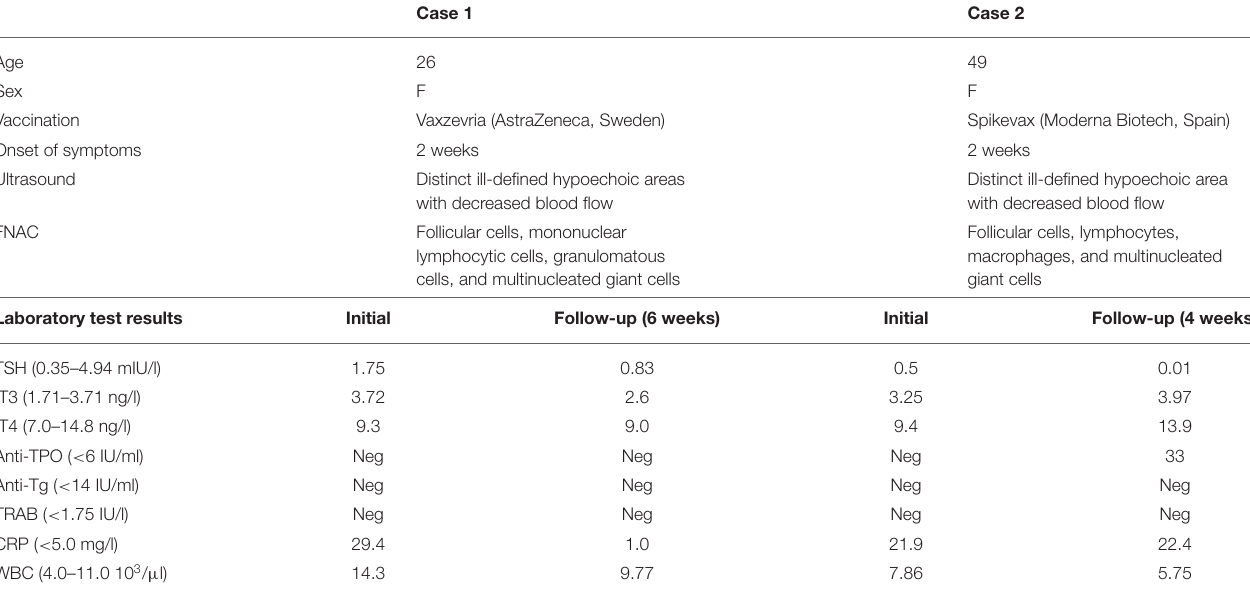
TABLE 1 | Patient characteristics and test